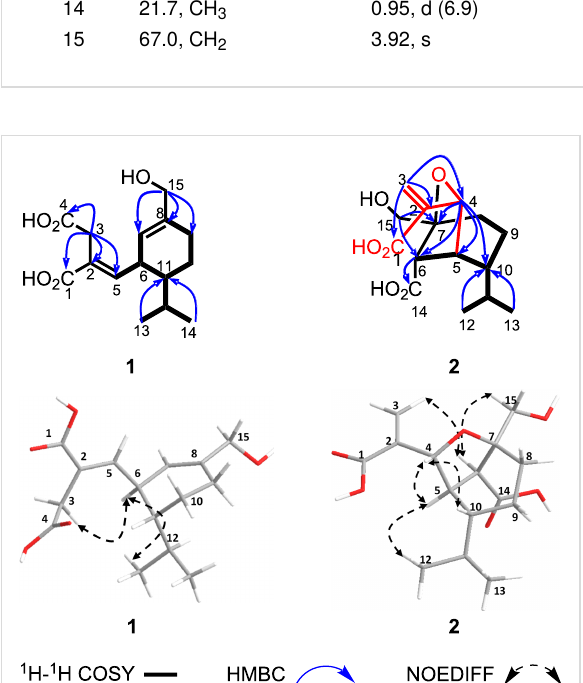
Figure 2: 1 H- 1 H COSY, key HMBC, and NOEDIFF data of com- pounds 1 and 2 . positive Cotton effect at 227 nm ( Δε +4.3, c 0.0008, MeOH), the same sign as that of compound 3 , ( λ max : 227 nm, Δε +4.8, c 0.0008 M, MeOH) [8] (Figure 3). Accordingly, C-11 had an R configuration. The observed specific rotation of compound 1 , +46.1 ( c 0.67, MeOH), was similar to that of compound